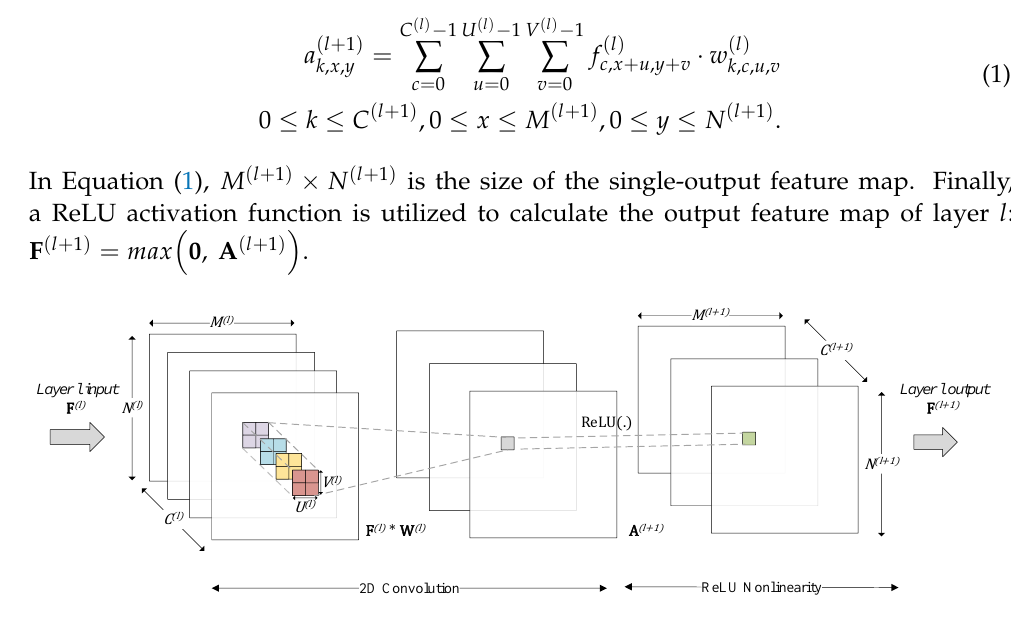
Figure 2. General structure of a convolutional layer. Convolutional kernels are first applied to the input feature map, and then, a nonlinear activation function is utilized to calculate the output feature